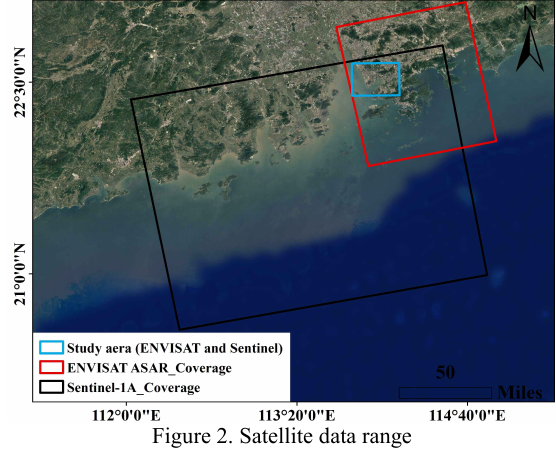
Figure 2. Satellite data range